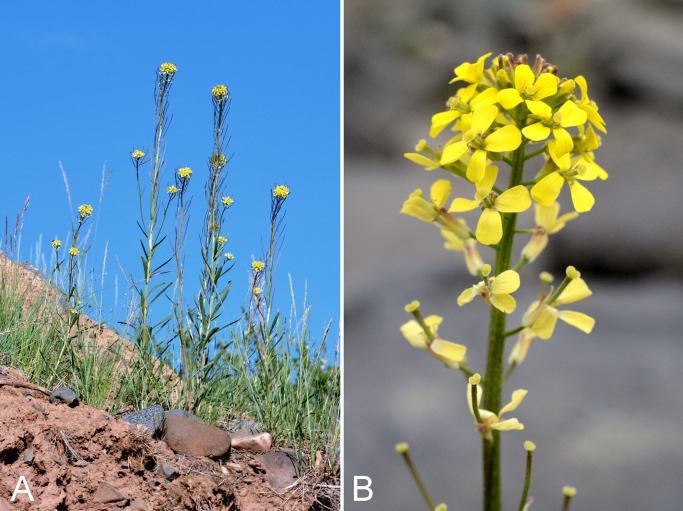
Erysimum coarctatum.(A) Habit, Saarela et al. 3471. (B) Inflorescence, Saarela et al. 4124. Photographs by P. C. Sokoloff (A) and R. D. Bull (B).